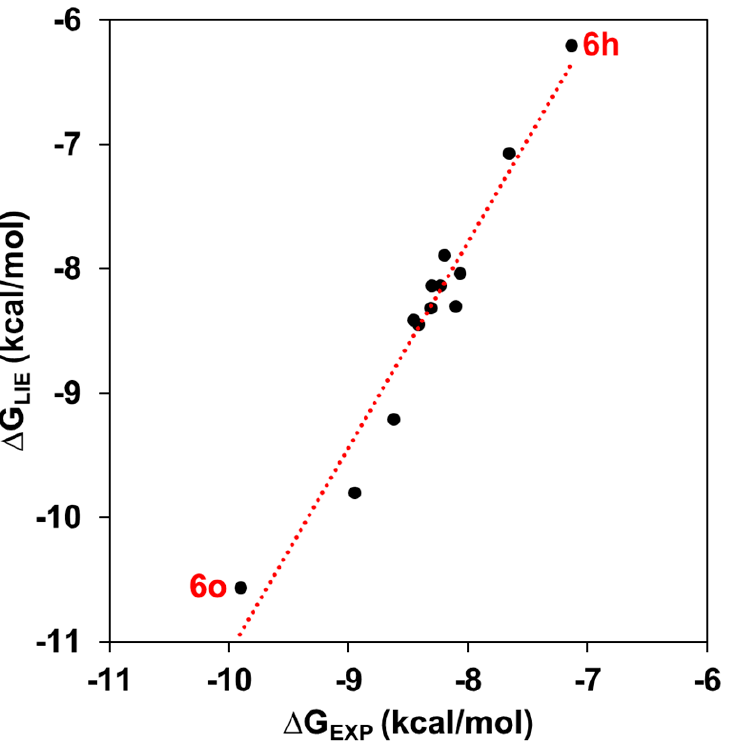
Figure 3. Calculated LIE ( ∆ G LIE ) vs. experimental ( ∆ G EXP ) binding free energies (Kcal/mol). The red dashed line represents the perfect agreement between ∆ G LIE and ∆ G EXP .